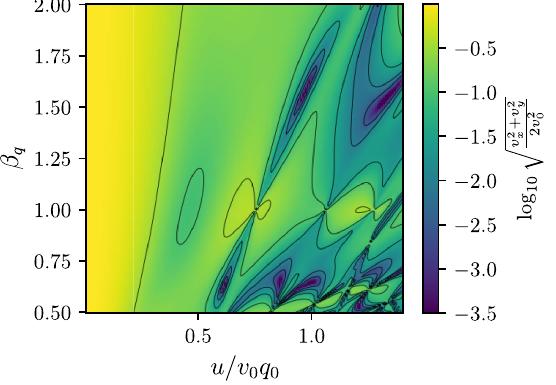
FIG. 9. The “ absolute Dirac velocity ” of the Dirac cone at charge neutrality of the Hamiltonian Eq. (C2) [similar to Fig 5(a)]. The dark valleys are points of vanishing